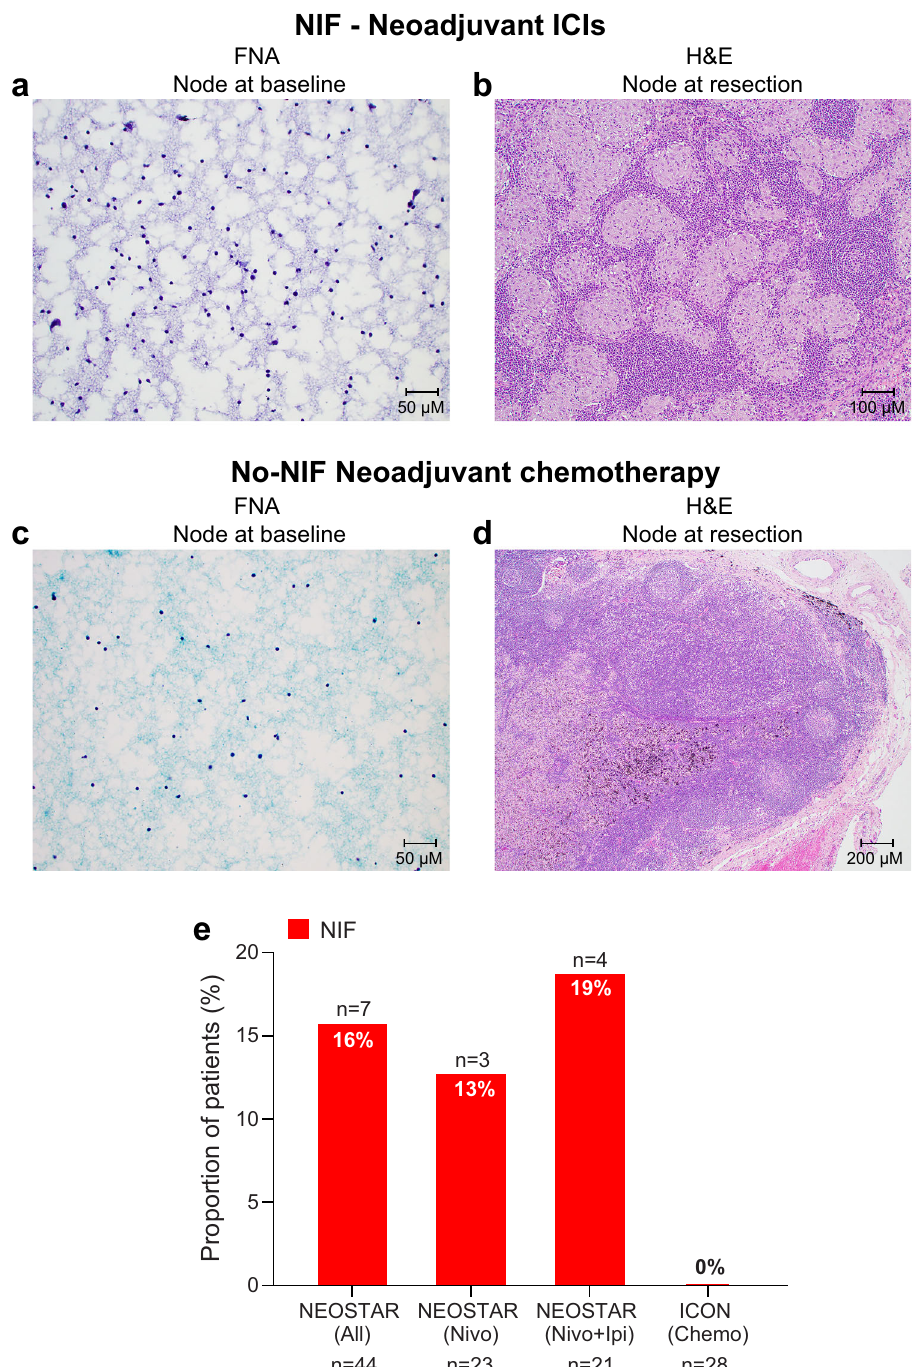
Fig. 2 Histopathological features of nodal specimens pre- and post-neoadjuvant therapy in NEOSTAR and ICON patients. a Illustrative FNA image from preoperative mediastinal staging by EBUS in NEOSTAR NIF patient did not demonstrate granulomatous in fl ammation within examined nodes (station 4 L pictured; Papanicolaou, x20). b Resected nodal specimen in NEOSTAR NIF patient following ICIs demonstrating a diffuse non-caseating granulomatous in fl ammatory reaction (station 11 R pictured; hematoxylin and eosin, x10). c Illustrative FNA image from preoperative mediastinal staging by EBUS in ICON No-NIF patient did not demonstrate granulomatous in fl ammation within examined nodes (station 7 pictured; Papanicolaou, x20). d Resected nodal specimen following neoadjuvant chemotherapy in a patient with No-NIF from ICON cohort with the absence of diffuse non-caseating granulomatous in fl ammatory reaction (station 7 pictured; hematoxylin and eosin, x4). e Proportions of patients with NIF, characterized by abnormal nodes on imaging that are devoid of cancer and contain de novo non-caseating granulomas in NEOSTAR ( n = 44) and ICON ( n = 28) patient cohorts. The red bars depict the proportions of patients with NIF. Analyses related to the presented micrographs were conducted once. NIF, nodal immune fl are; ICIs, immune checkpoint inhibitors; ICON, ImmunogenomiC prO fi ling in NSCLC; EBUS, endobronchial ultrasound; FNA, fi ne needle aspiration. Source data for panel ( e ) are provided as a Source Data fi